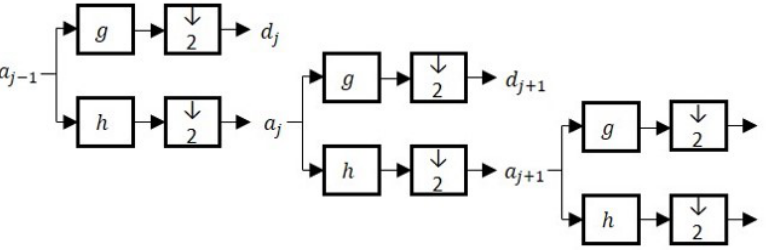
Figure 1. Schematic diagram of the decimated wavelet transforms (DWT), where h and g represent the high- and low-pass filters, and a and d represent the approximate and detail signals.